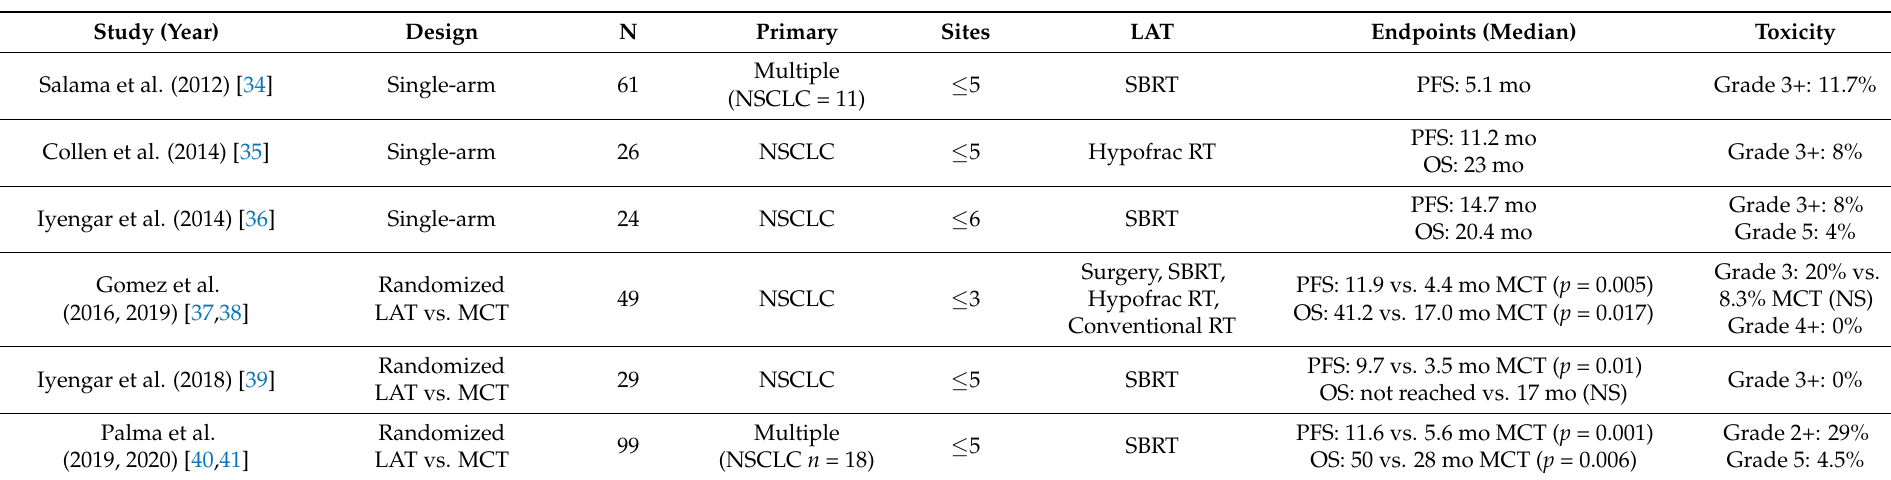
Table 1. Selected prospective trials of radiation as local ablative therapy for oligometastatic